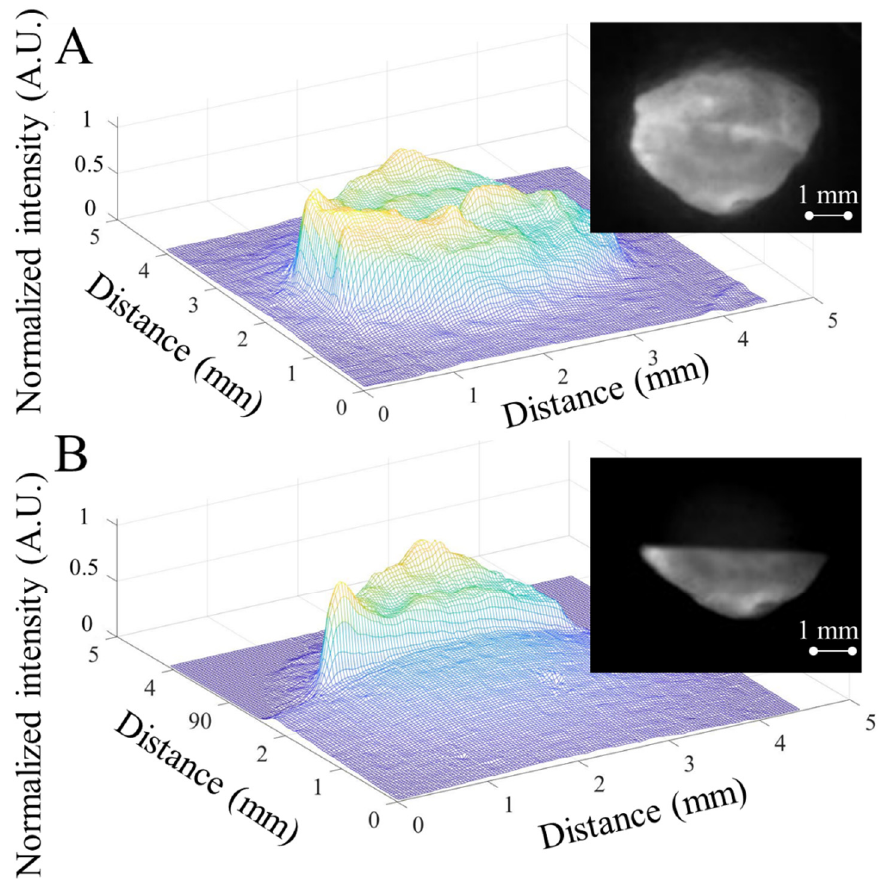
Figure 9. ( A ). The actual image and light intensity distribution graph of tumor tissue fully covered by the dual——channel NLC shutter (with both channels deactivated) under 1064 nm ICG NIR. ( B ). The actual image and light intensity distribution graph of tumor tissue fully covered by the dual −− channel NLC shutter (with top channel activated) under 1064 nm ICG NIR.